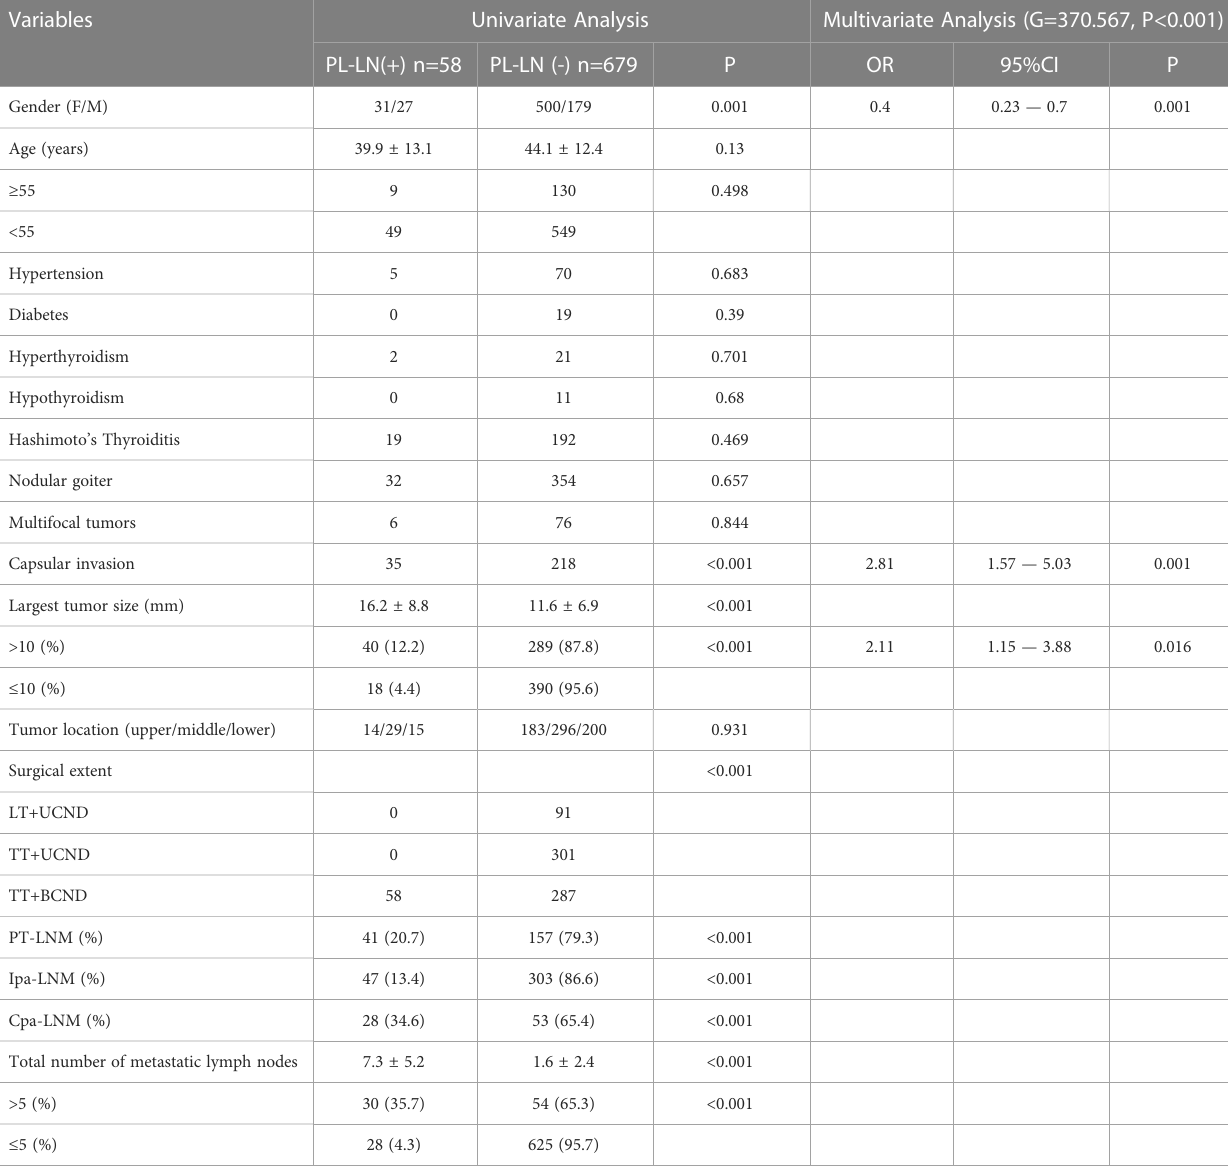
TABLE 2 The risk factors for prelaryngeal lymph node metastasis.